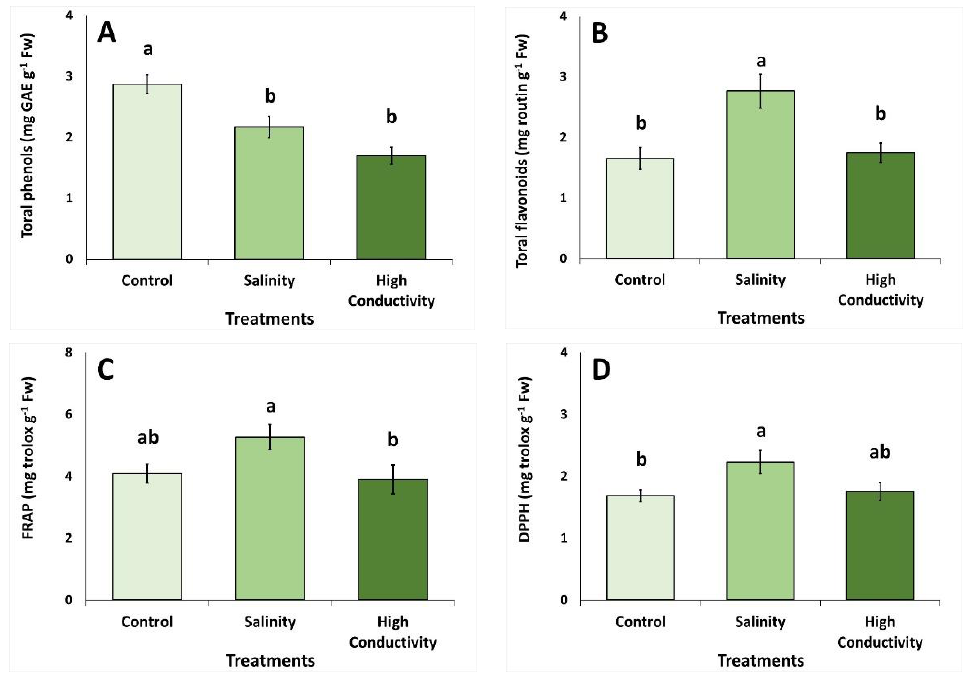
Figure 3. Influence of salinity (75 mM NaCl) and high electrical conductivity (8.5 dS m − 1 ) on ( A ) total phenols (mg GAE g − 1 fw), ( B ) total flavonoids (mg routin g − 1 fw), and antioxidant activity, assayed by ( C ) FRAP and ( D ) DPPH (mg trolox g − 1 fw) methods, on verbena plants grown in perlite substrate. Significant differences ( p < 0.05) are indicated by different letters above each bar. Error bars show SE (n = 4).